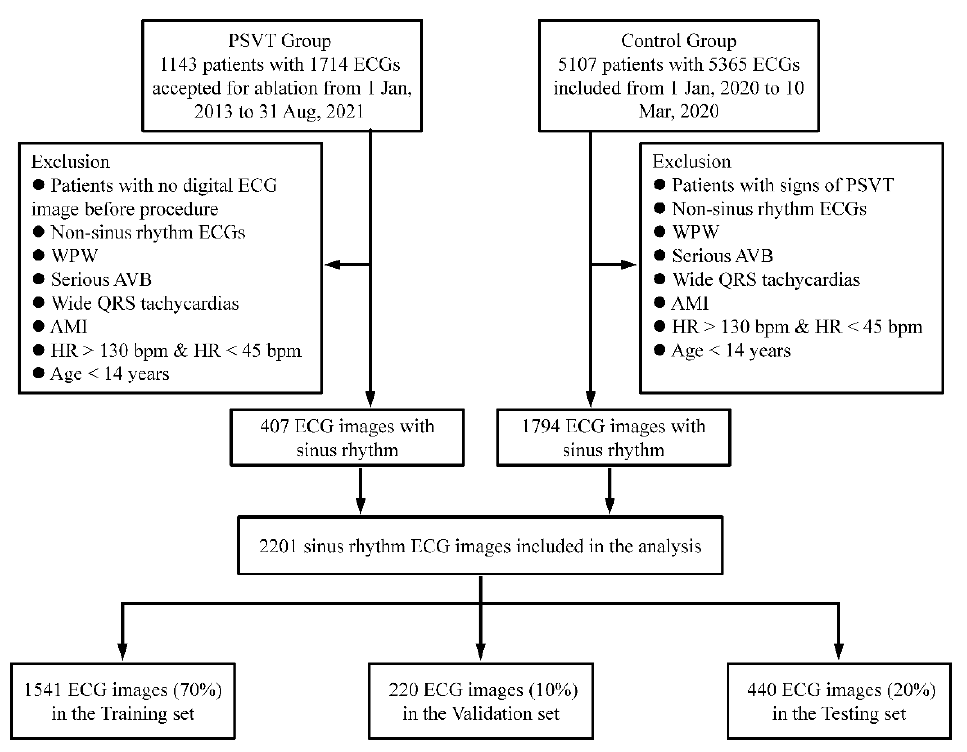
Figure 1. Flowchart of data collection and dataset creation. A total of 1714 ECGs of 1143 patients with PSVT and 5365 ECGs of 5107 control patients were collected. After exclusion of non-sinus-rhythm ECGs, WPW syndrome, serious AVB, wide QRS tachycardias, acute myocardial infarction, HR > 130 bpm, HR < 45 bpm and age < 14 years, a total of 2201 ECGs (407 ECGs for PSVT group and 1794 ECGs for control group) were included in this study. These ECGs were randomly divided into three datasets: a training set (n = 1541), validation set (n = 220) and testing set (n = 440).